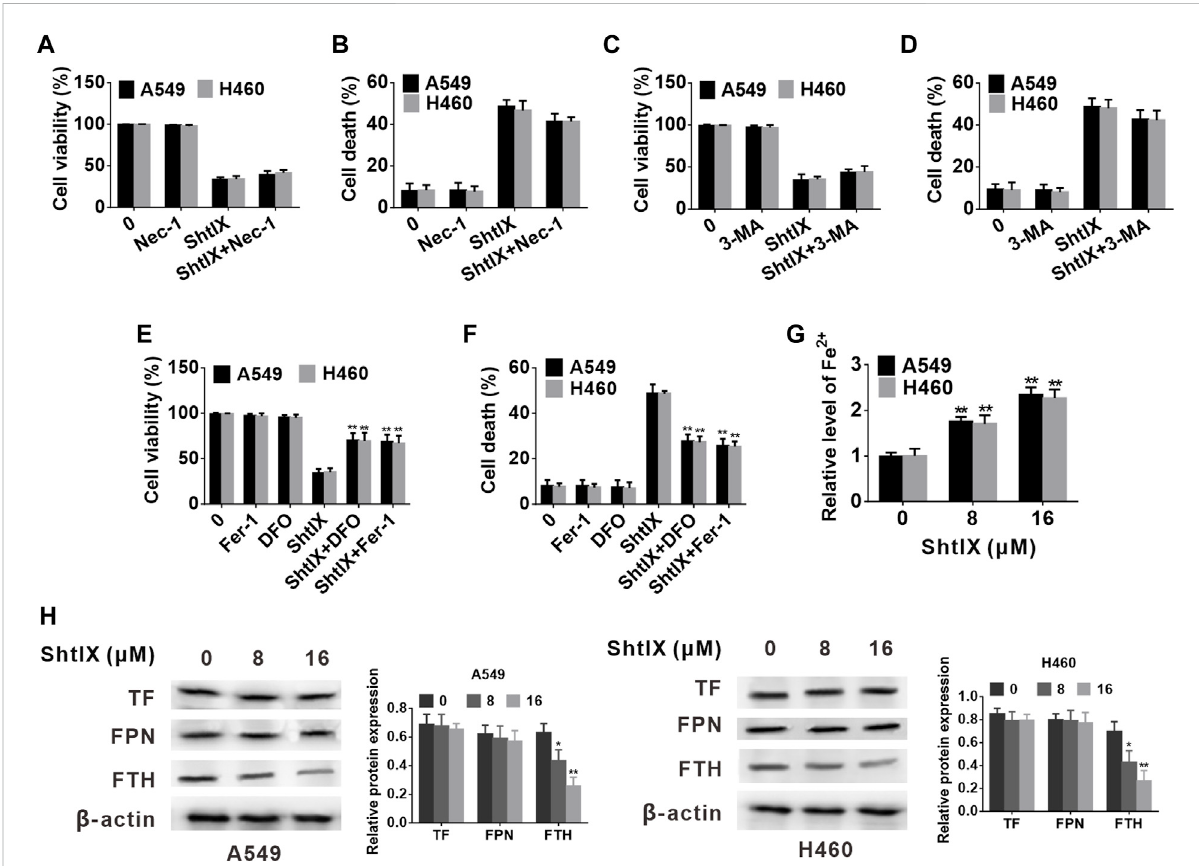
FIGURE 4 ShtIXinducesNSCLCcelldeathisassociatedtoironmetabolism. (A,B) A549andH460cellsviabilityandcelldeathweredeterminedafter being treated with 16 μ MShtIX inthe presence or absence of Nec-1 (C,D) A549 and H460 cells viability andcell death weredetermined after being treated with 16 μ M ShtIX in the presence or absence of 3-MA. (E,F) A549 and H460 cells viability and cell death were determined after being treated with 16 μ M ShtIX in the presence or absence of DFO or Fer-1. (G) Fe 2+ content in A549 and H460 cells was observed after cells were treated with indicateddoseofShtIXfor24 h, (H) Ironhomeostasis-relatedproteinswereevaluatedbywesternblot.Dataareexpressedasmean±SDoftriplicate experiment. * p < 0.05, ** p <